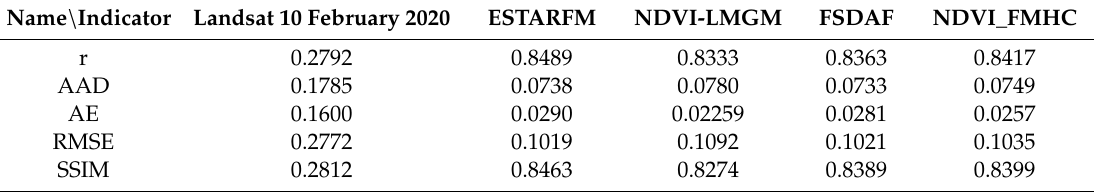
Table 6. Accuracy comparison of four fusion methods in fire